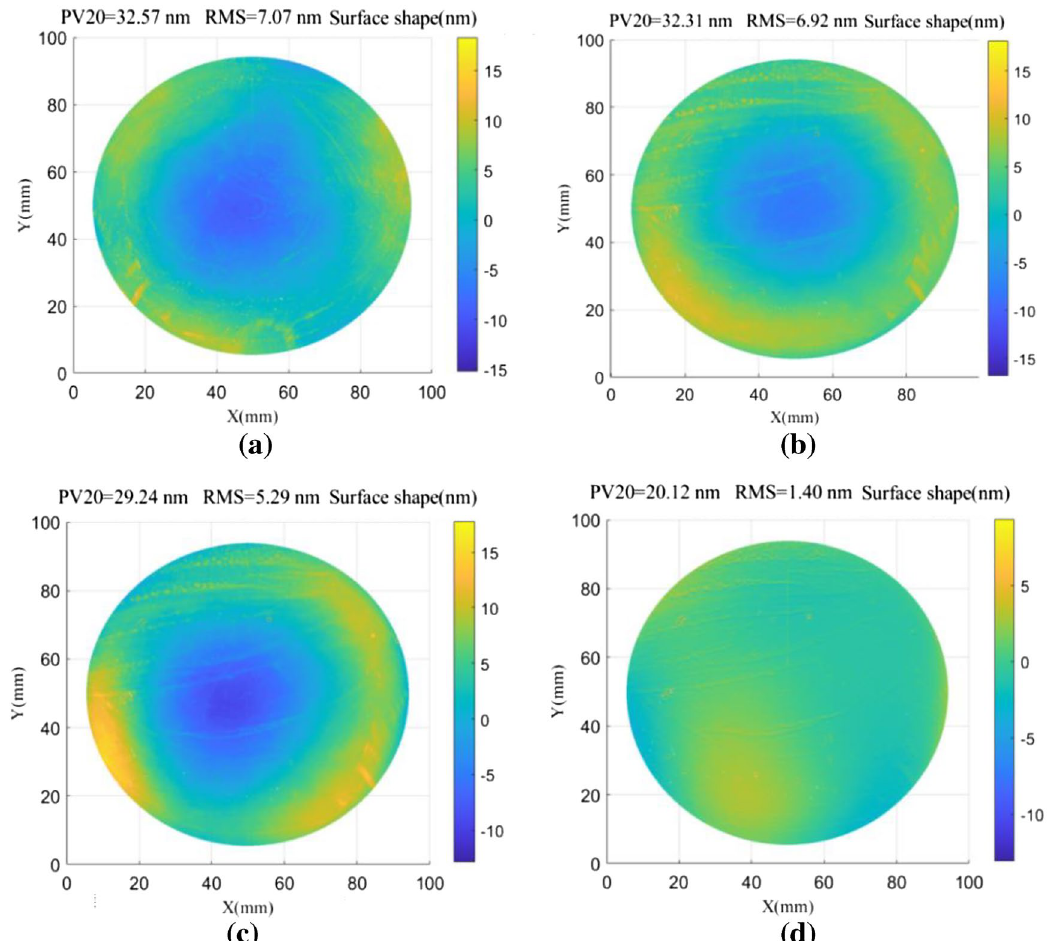
Figure 6. Wavefront reconstruction of measured surfaces using various spectrum compensation methods, including: ( a ) direct zero filling, ( b ) average neighboring points, and ( c ) conjugate double shift. ( d ) Surface shape deviations for the results shown in ( b and c